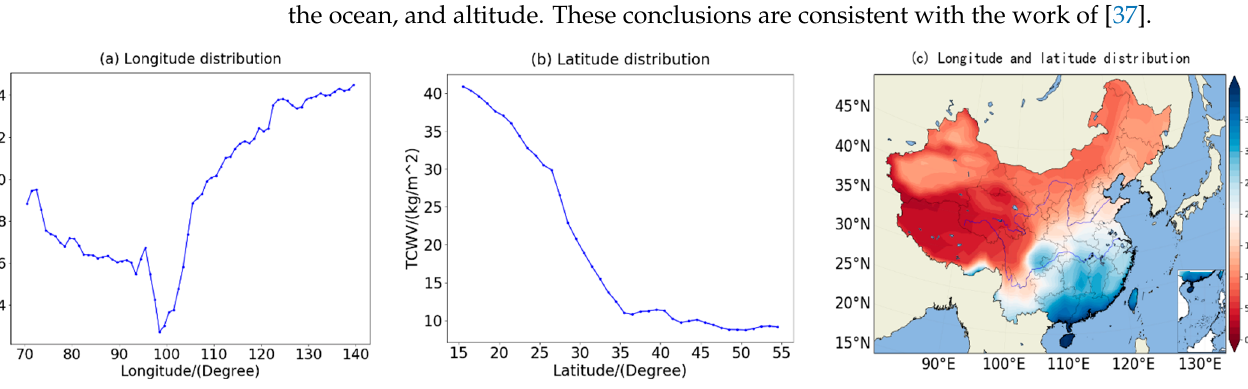
Figure 1. Spatial distribution of TCWV during 2002–2022 in China. ( a ) Longitude distribution. ( b ) Latitude distribution. ( c ) Longitude and latitude distribution.